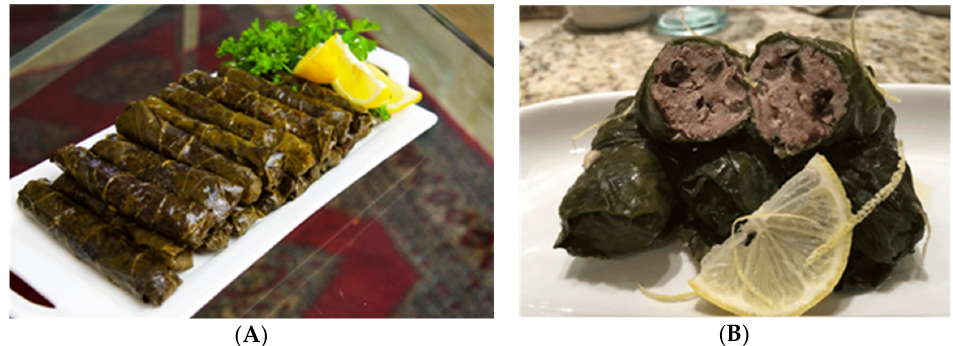
Figure 6. ‘Sarma’ (SAR’-mah) and ‘Dolma’ (dole-MAH’) in Turkish cooking. ‘Sarma’ means ‘wrapped thing (( A ) cooked spicy rice wrapped in grape leaves). ‘Dolma’ means ‘stuffed thing’; (( B ) grape leaves rolls stuffed with meat). These are general terms used for many varieties of vegetables and leaves, including grape leaves, rice fillings and stuffed with